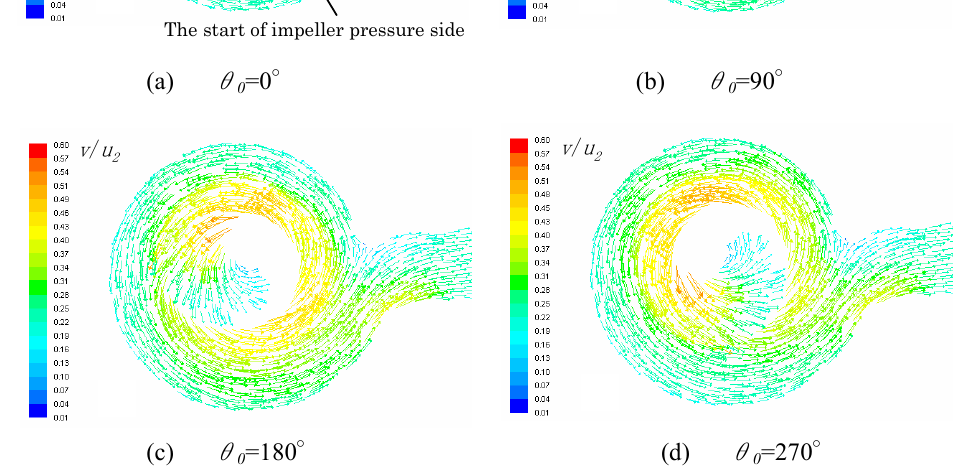
Fig. 9 Absolute velocity vectors ( φ =0.025)